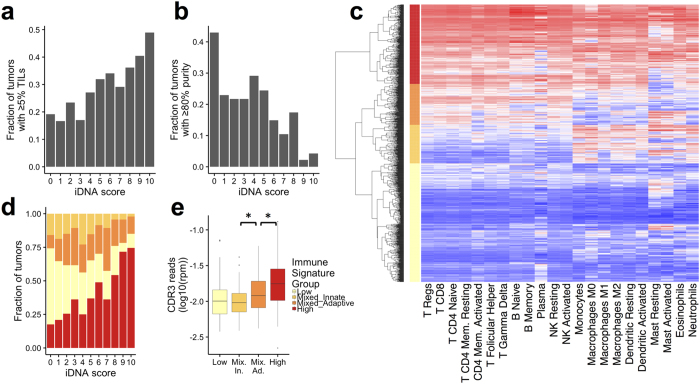
Association between iDNA score and the tumor immune-environment.(a) Fraction of tumors with more than 5% TILs in each iDNA score. (b) Fraction of tumors with more than 80% tumor purity in each iDNA score. (c) Clustering of 1072 breast tumors according to the GSVA score (red:high, blue:low) of 22 immune gene signatures. The four main clusters, high (red), mixed adaptive (dark orange), mixed innate (light orange) and low (yellow) are labeled on the y-axis. (d) Distribution of tumors between the four immune signature groups with increasing iDNA scores. (e) Distribution of the CDR3 reads normalized abundance in tumors of the four immune signature groups (*) p < 0.01, t-test. Only tumors with CDR3 reads are included.